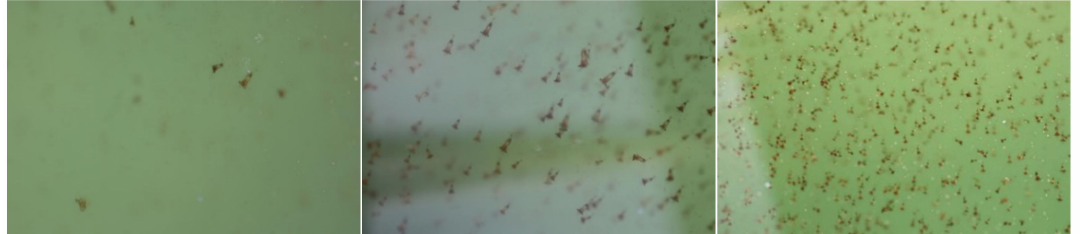
Figure 9. ( left ) Less dense category, ( middle ) medium dense category, and ( right ) high dense category.